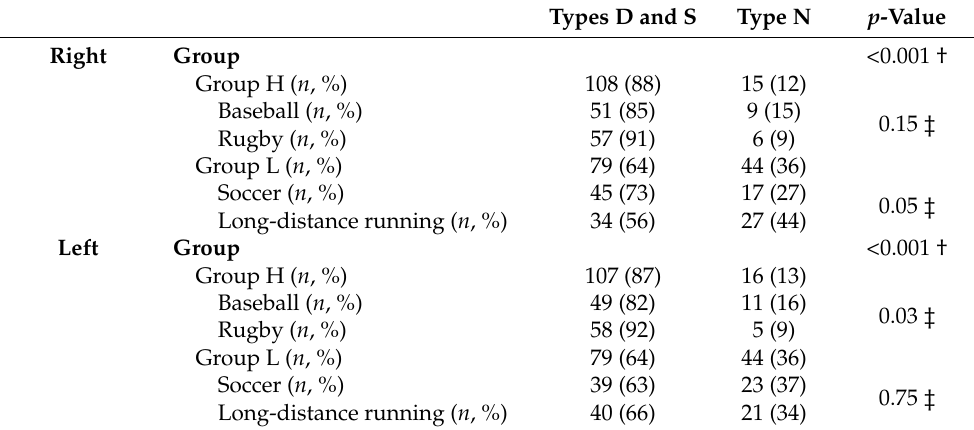
occurrence rate of hypermobility within each group.